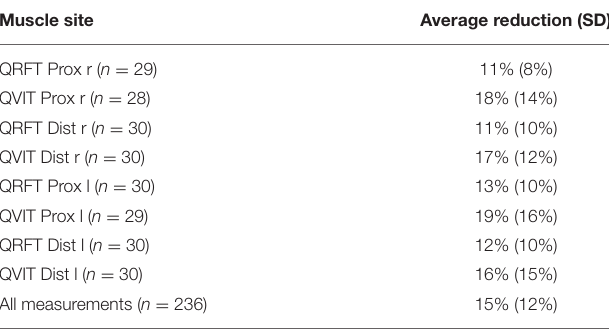
TABLE 2 | Average percent reduction of muscle thickness after 5 days of ICU